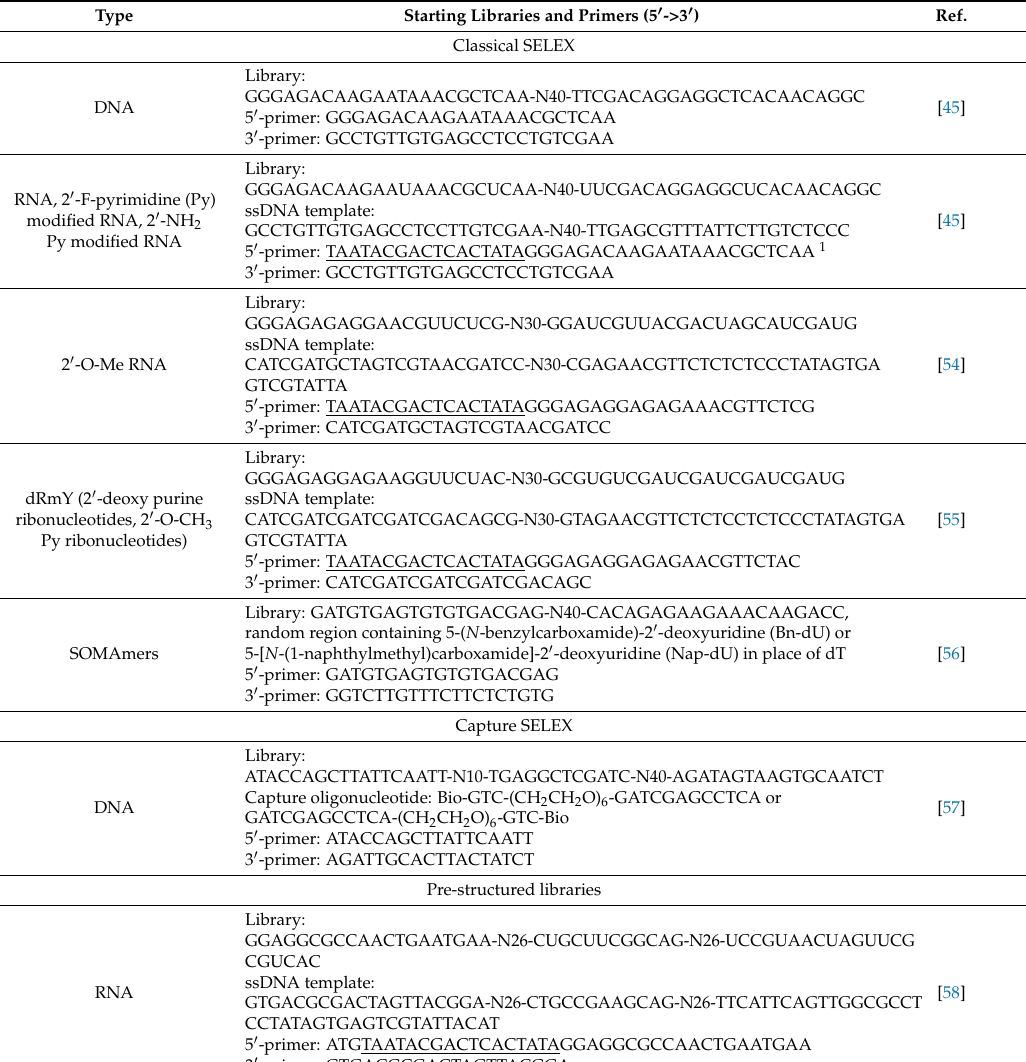
Table 1. Examples of starting libraries for SELEX. SOMAmers, Slow Off-rate Modified